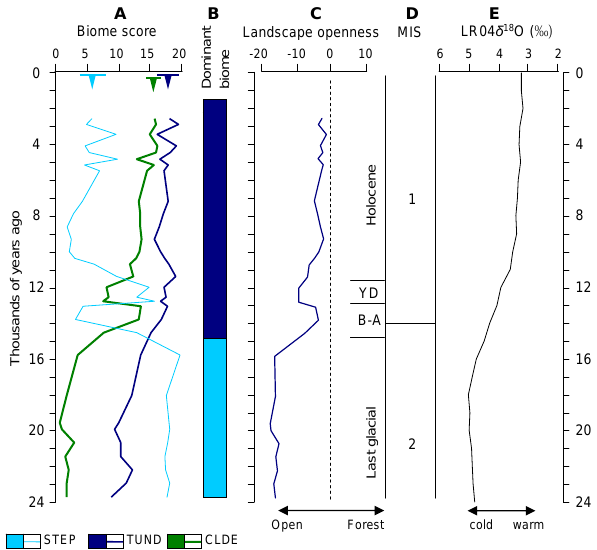
Fig. 3. Summary diagram for the last ∼ 24ka showing the (A) time series of individual biomes (triangles indicate the modern mean score of each respective biome; horizontal bars indicate the 95% uncertainty ranges); (B) dominant biomes; (C) characteristic of landscape openness calculated as the difference between the max- imum score of forest biomes (MSFB) and the maximum score of open biomes (MSOB) at each level; and (D) marine isotope stage (MIS) boundaries and (E) stack of 57 globally distributed benthic δ 18 O records (after Lisiecki and Raymo, 2005). The Younger Dryas is indicated by YD, and the Bølling–Allerød is indicated by